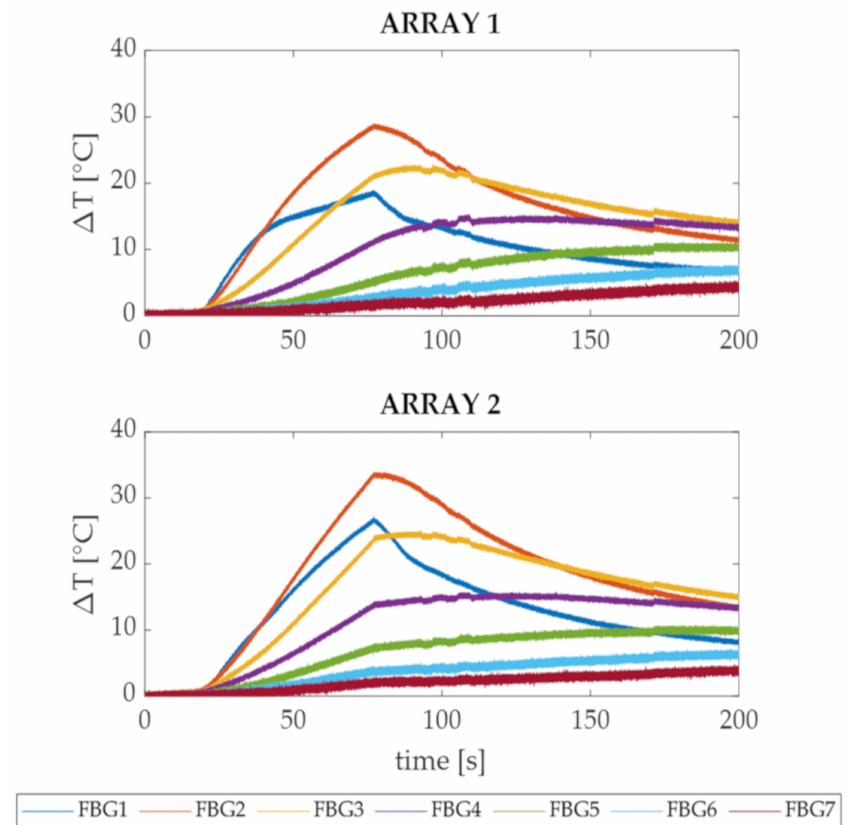
Figure 7. Temperature variations in time recorded by the Arrays 1 and 2 during Trial 2 (RFA performed at 60 W). In the upper image, the seven trends relative to the FBGs housed in Array 1 are shown, while in the bottom image the seven trends relative to the FBGs housed in Array 2 are reported. The pre-treatment phase (i.e., 0 s–25 s), the RFA phase (i.e., 25 s–85 s) and the cooling phase (i.e., 85 s–200 s) are clearly